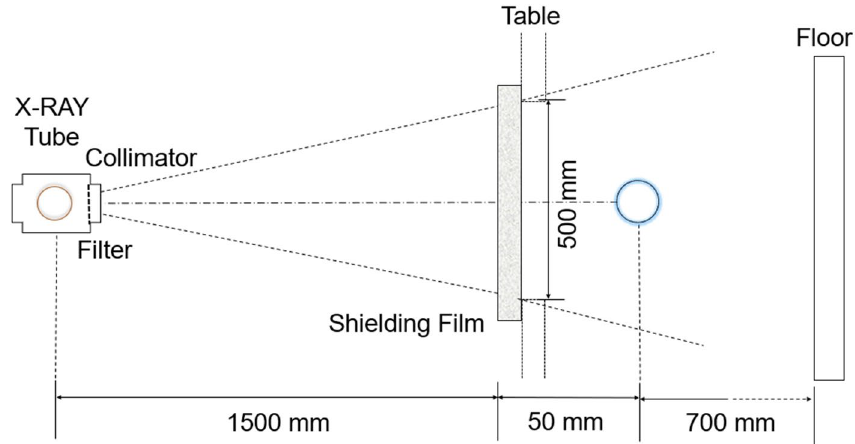
Figure 8. X-ray experiment to analyze the shielding performance of the shielding